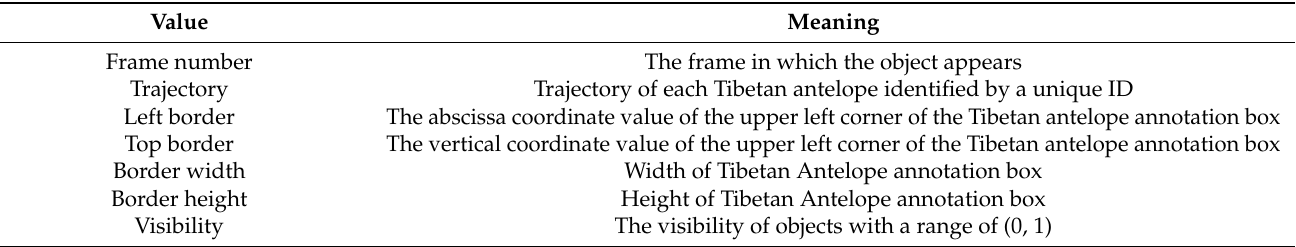
Table 1. Format of input or output